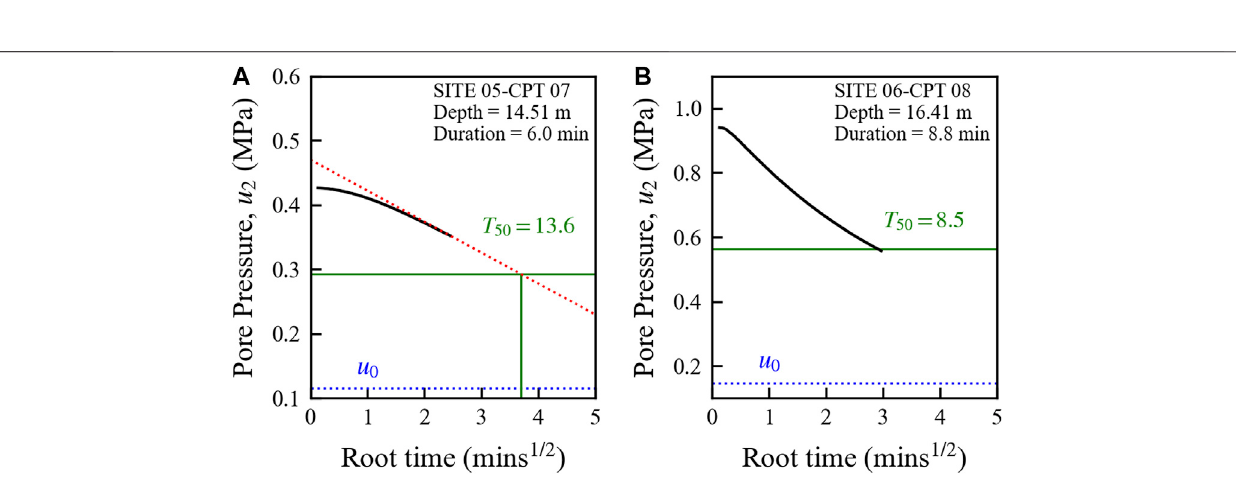
Frontiers in Built Environment |